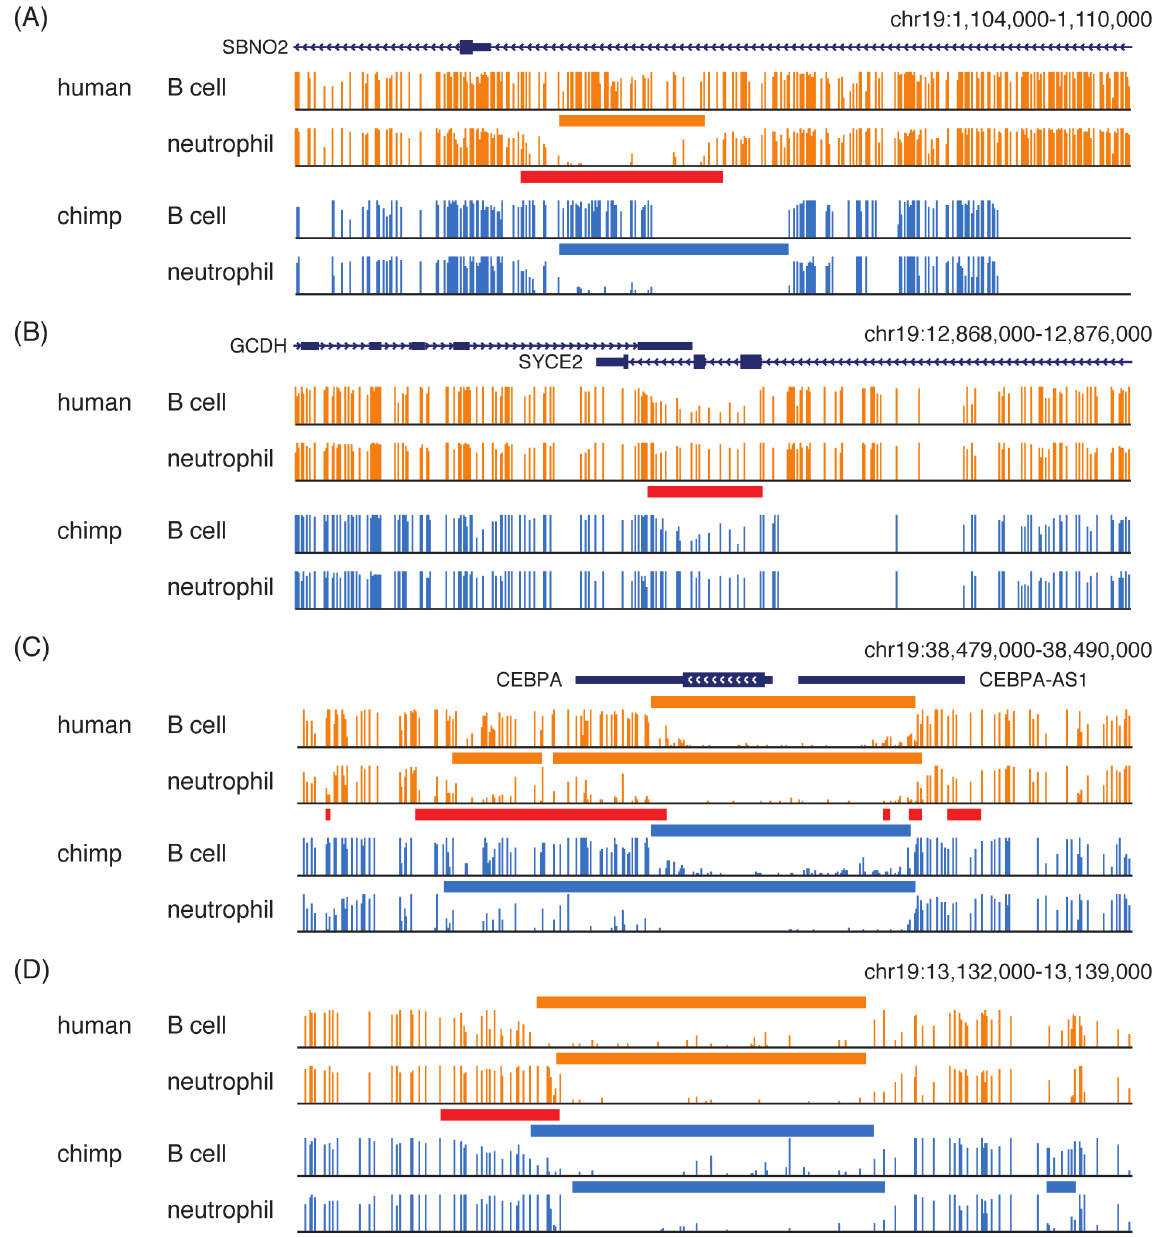
Figure 5. Evolutionary support for commonly observed types of differential methylation. (A) differential presense of an HMR; (B) partial difference in methylation level; (C) shifting of HMR boundaries; (D) difference in precision of HMR boundaries. Orange bars: HMRs in human; Blue bars: HMRs in chimp; Red bars: DMRs between B cells and neutrophils.